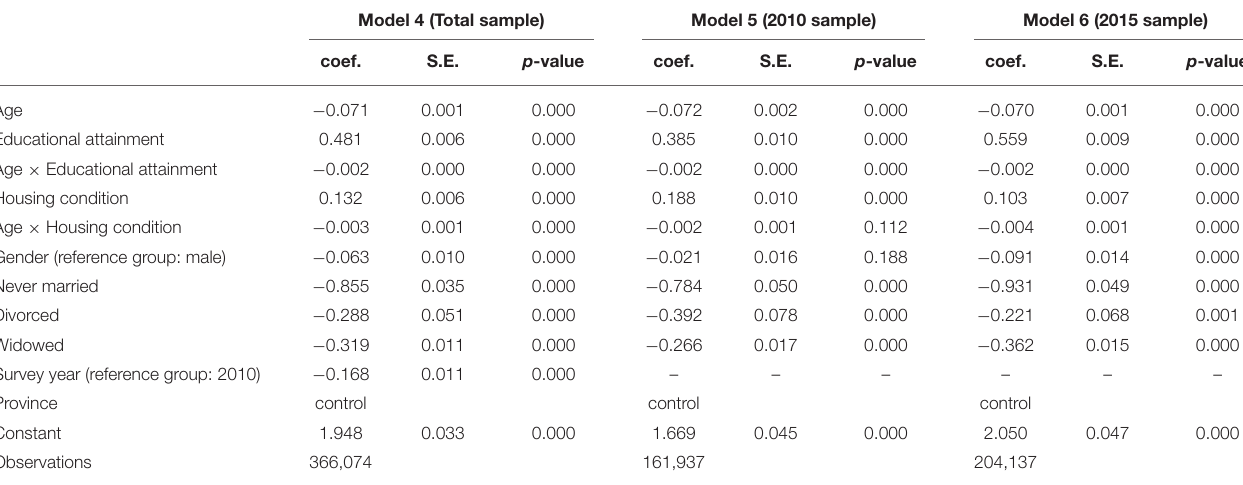
TABLE 4 | Binary logistic regression models with age